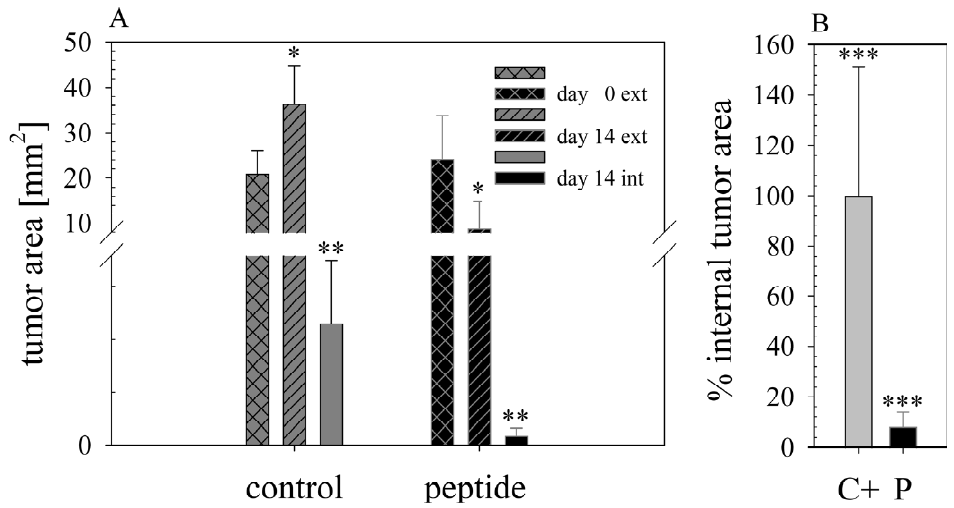
Figure 12. ( A ): Tumor areas, measured externally (in vivo), of control ( n = 5) and peptide group ( n = 8) are compared on day 0 upon start of treatment and day 14 at the end of treatment with 11 doses of buffer or peptide RDP22 (2.2 mg in total), respectively. Tumor regression is significant in the peptide group. Upon day 14 histological staining allowed determination of internal (real, ex vivo) tumor size of biopsies. Again, peptide treatment induced strong and nearly complete regression of tumors. On the y ‐ scale (tumor area) a break was inserted from 3.6 to 8 mm 2 for clearer comparison of all sizes. Further the lower area was enlarged for better visualization of the effects. ( B ): Percentage of internal tumor area is reduced by >90% in the peptide group. *, ** and ***: Respective tumor sizes differ significantly (student’s t ‐ test, p < 0.001).